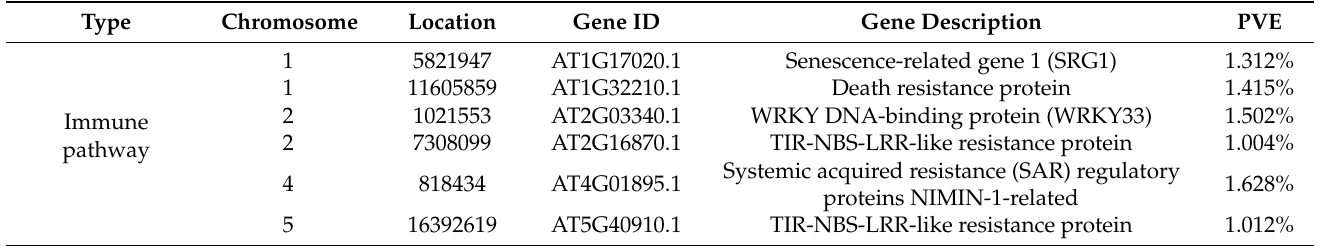
Table 1. Functional annotation of QTLs associated with allometry between leaf length and leaf area.